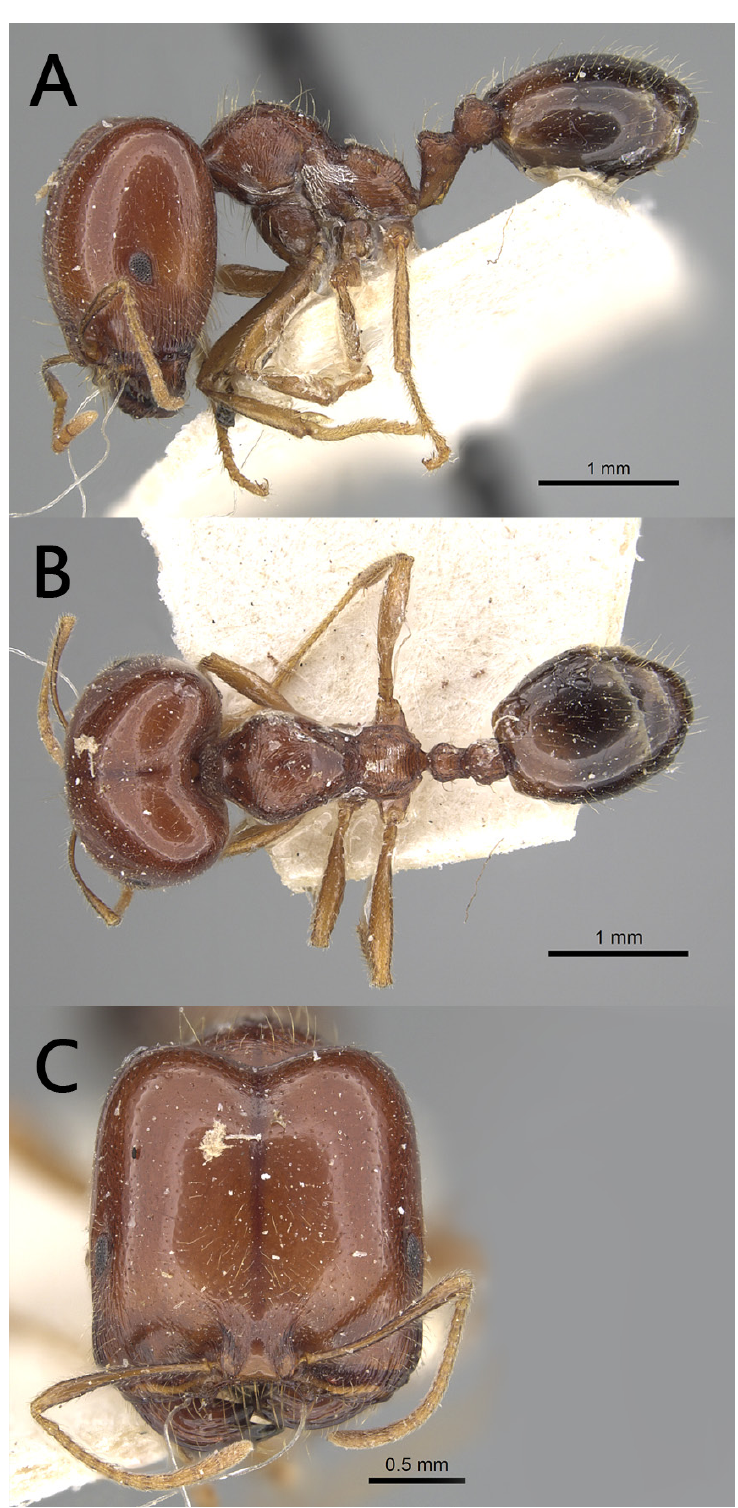
Fig. 5. Trichomyrmex abyssinicus (Forel, 1894a) , lectotype, worker (CASENT0249906) . A . Body in profile. B . Body in dorsal view. C . Head in full-face view (photos: Shannon